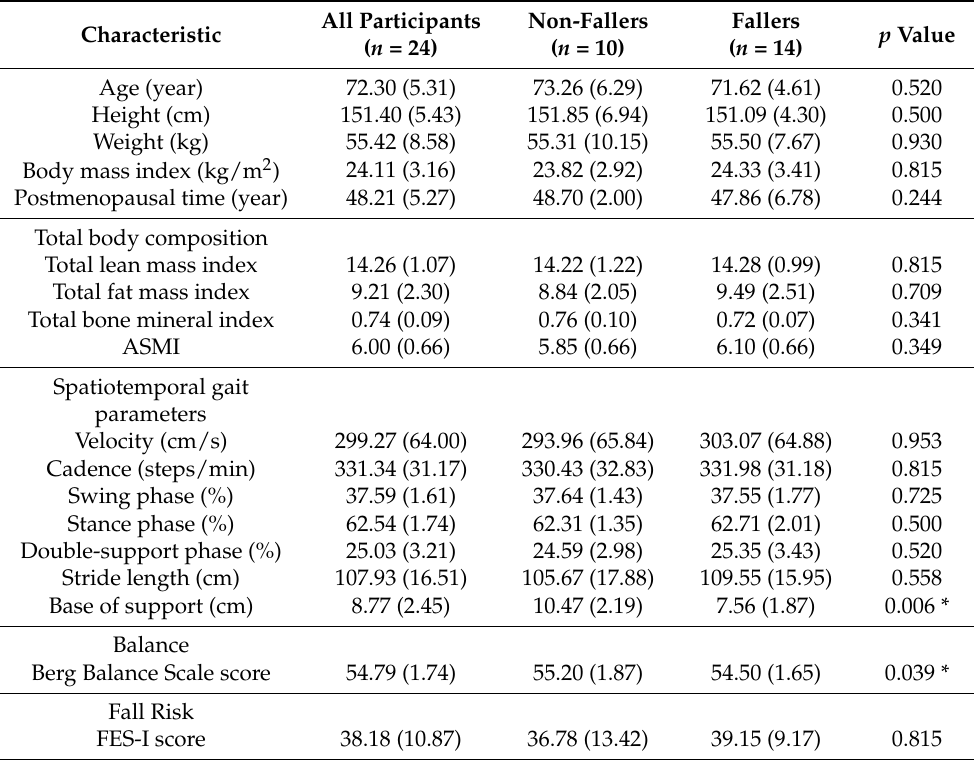
Table 1. Differences in mean (SD) lean mass and spatiotemporal gait parameters of fallers vs. non-fallers.